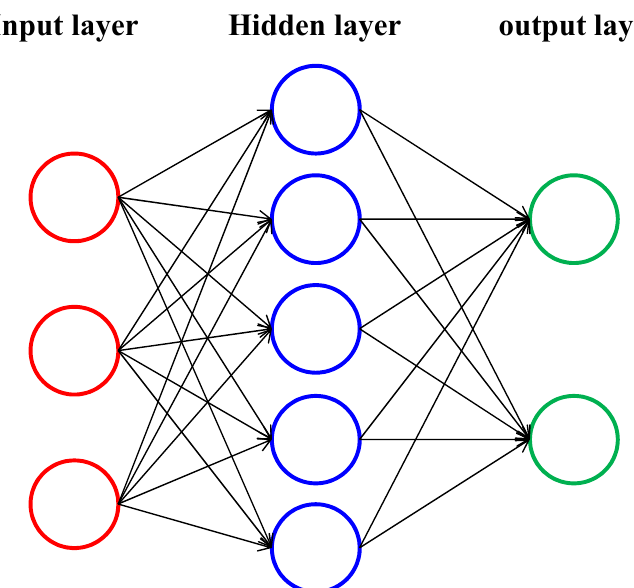
Figure 3. Topological structure of a 3-layer perceptron with three inputs, two outputs, and the hidden layer containing five neurons.